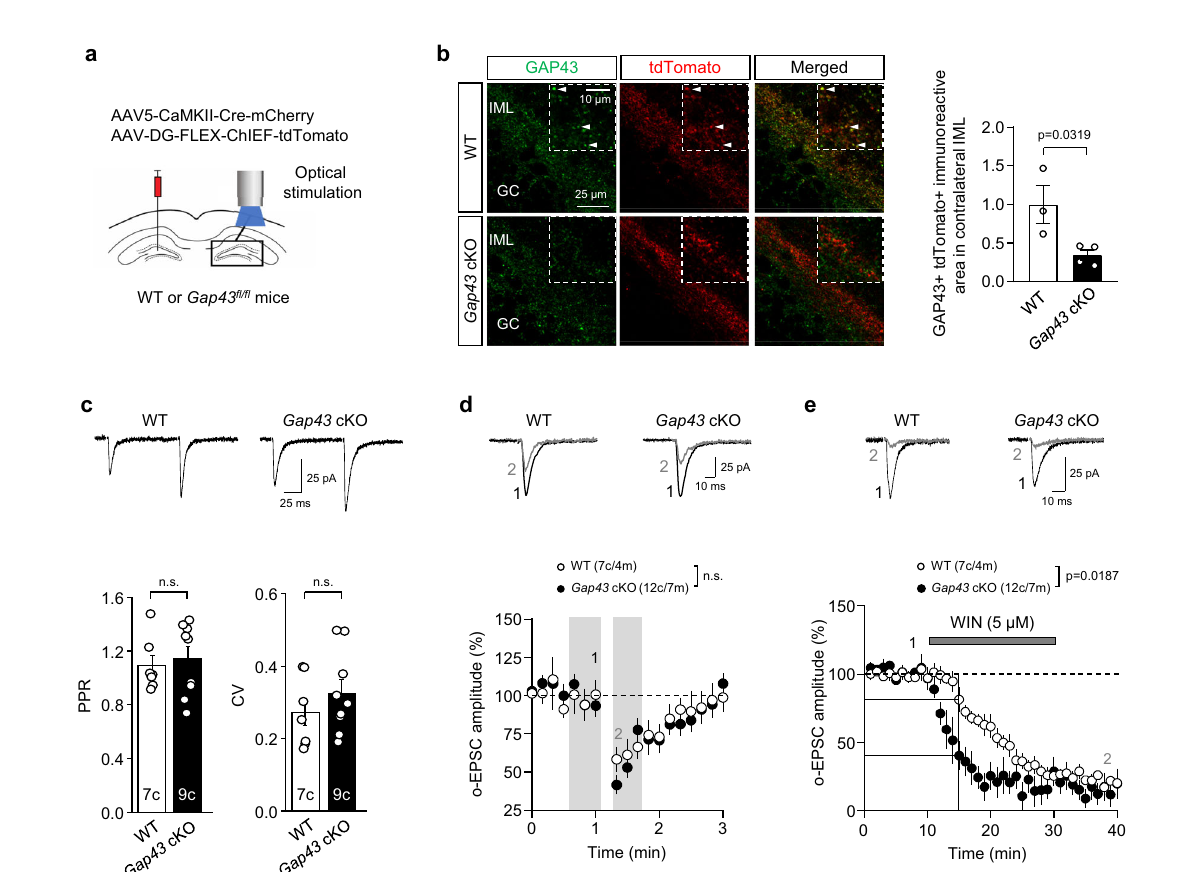
Fig. 4 | Phosphorylated GAP43 inhibits CB1R function at MC-GC synapses. a Schematic diagram illustrating the injection of AAV1/2-CBA-CFP (control), AAV1/ 2-CBA-GAP43(S41A)-CFP or AAV1/2-CBA-GAP43(S41D)-CFP in the hilus of 3-week- old WT mice. Electrophysiological recordings were performed in the contralateral DG.Infrareddifferentialinterferencecontrast(left)and fl uorescence(right)images showingCFPexpressioninthecommissuralMCaxonterminalsinthecontralateral DG. Note the presence of CFP-positive fi bers in the IML and its absence in the GC layer.ThisCFP-expressionpatternwas observed inallinjected animals withsimilar results. b Whole-cellpatch-clamprecordingswereperformedonGCsfrominjected mice. Representative traces (top) and quanti fi cation bar graph (bottom) for basal PPR and CV are shown (means±SEM; c = cells; one-way ANOVA with Tukey ’ s multiplecomparisonstest). c EPSCsrecordedfrominjectedmiceuponAM251bath application (5 μ M, 10min). Representative EPSC traces, before and after AM251 application (top), and time-course summary plot (bottom) are shown [means± SEM, c = cells, m = mice; shaded areas indicate the time intervals at which the statistical analysis was conducted; one-way ANOVA with Tukey ’ s multiple